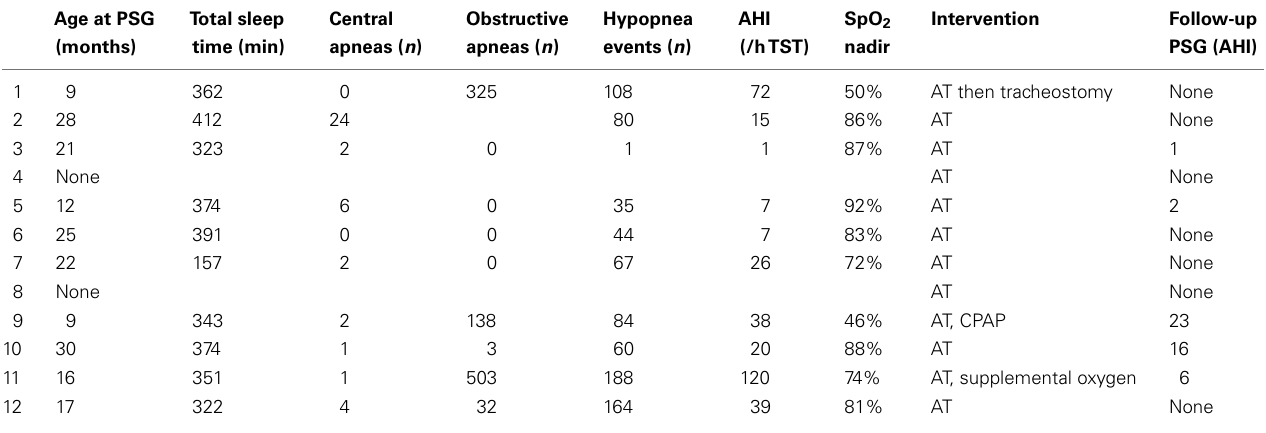
Table 2 | Polysomnography results and treatment